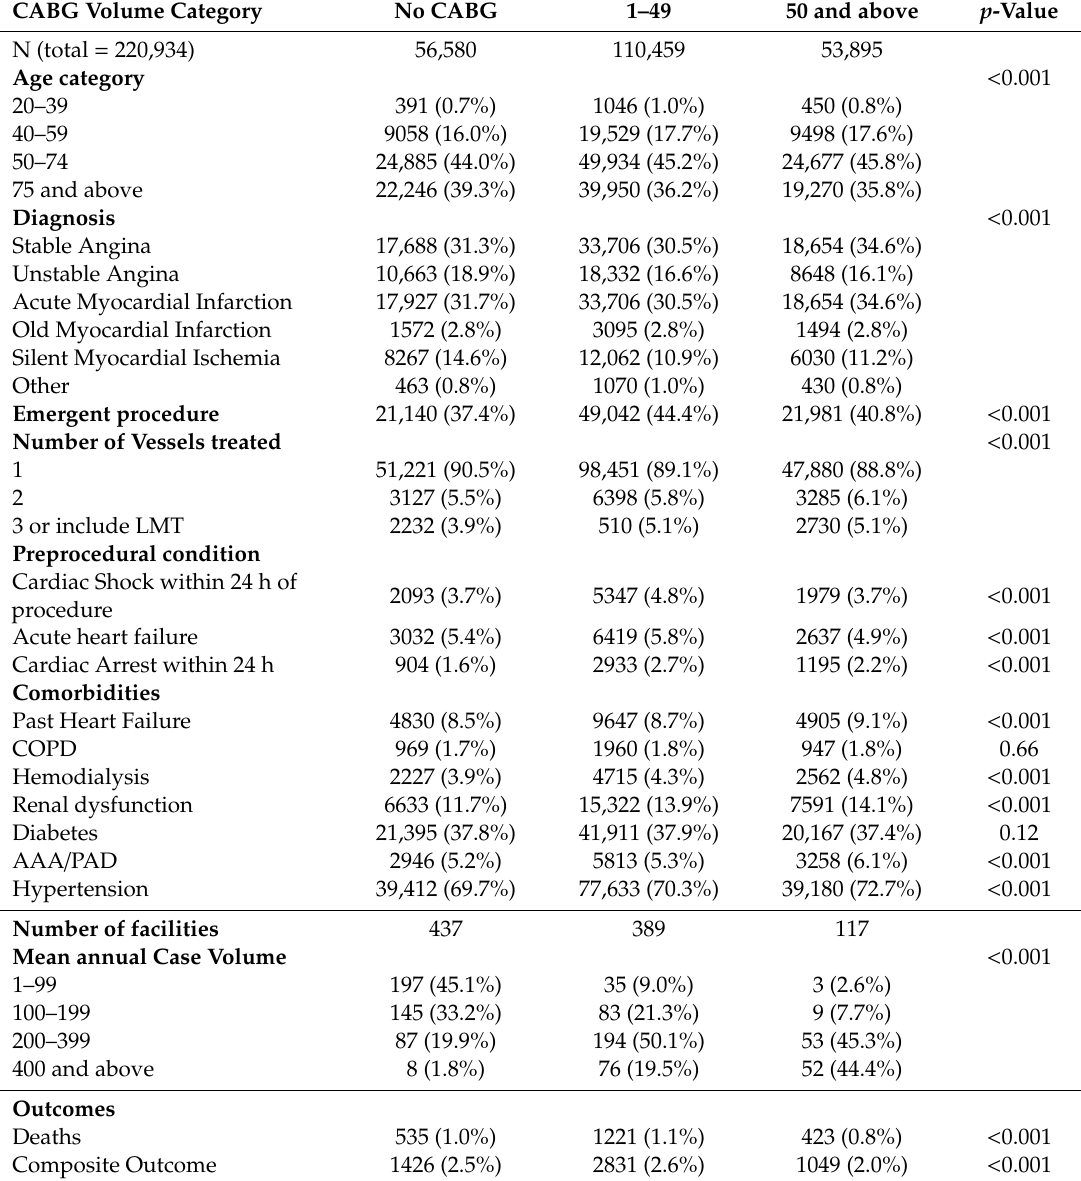
Table 1. Patient characteristics of percutaneous coronary intervention (PCI) patients by the absolute volume of coronary artery bypass grafting